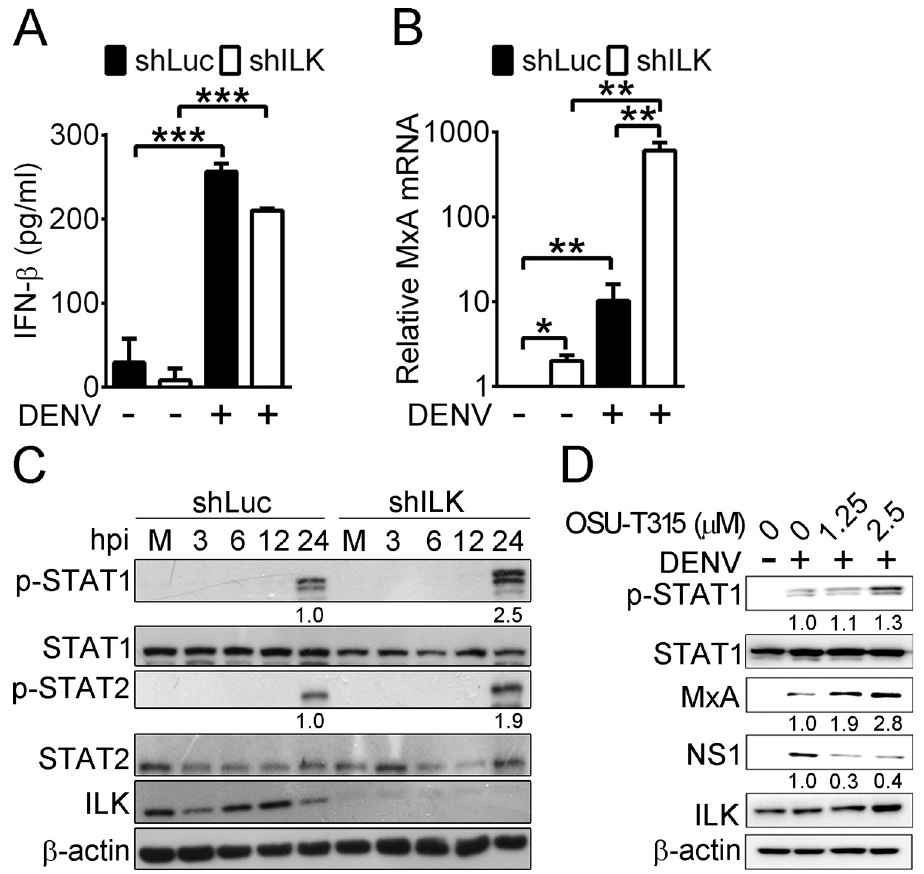
Fig 3. ILK attenuates IFN-induced STAT1/2 activation and ISG expression. ( A-B ) The protein levels of IFN- β ( A ) and mRNA levels of MxA ( B ) in control (shLuc) or ILK knockdown (shILK) A549 cells infected without (-) or with (+) DENV at 24 hours post-infection (hpi) are shown. The MxA level in control cells without DENV infection was set as 1. Data represent mean + SD (error bars). � p < 0.05, �� p < 0.01, ��� p < 0.001. ( C ) Representative western blots of phosphorylated (p-) and indicated proteins in mock- (M) and DENV-infected control or ILK knockdown A549 cells at indicated hpi are shown. The ratios of phosphorylated to total STAT1 and STAT2 relative to infected control cells at 24 hpi are shown. ( D ) Representative western blots of indicated proteins in A549 cells infected without (-) or with (+) DENV and treated with the indicated concentration of OSU-T315 for 24 hours are shown. The ratios of MxA and NS1 to β -actin as well as phosphorylated to total STAT1 relative to infected cells without OSU-T315 treatment are shown.